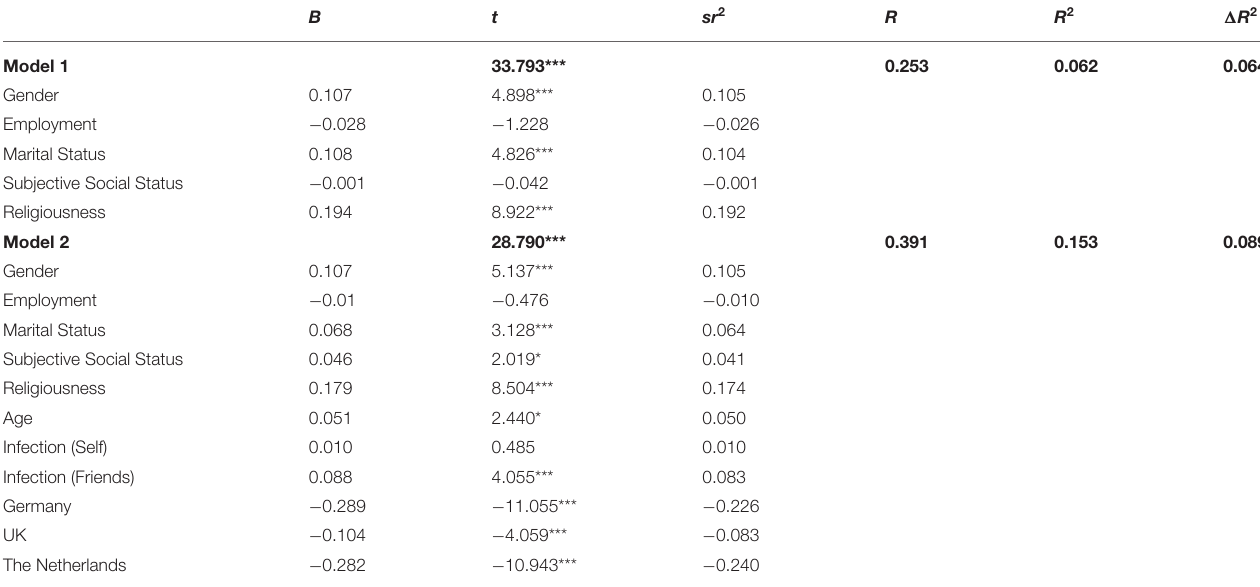
TABLE 1 | Hierarchical regression analysis in two steps for “anxiety about coronavirus” (standardized regression coefficients).